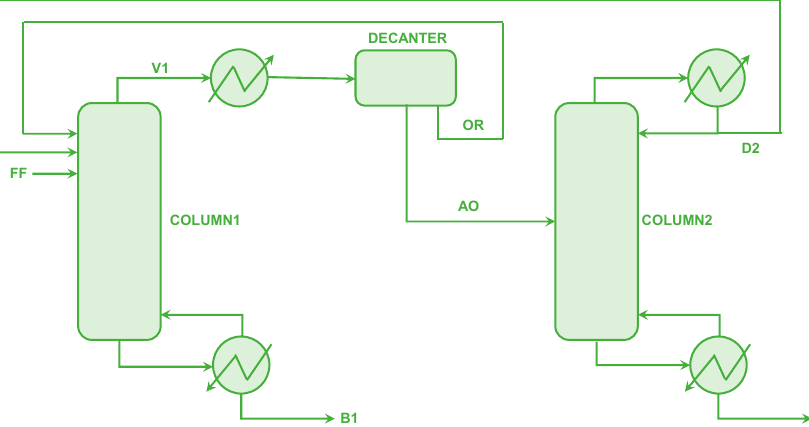
Figure 1. Scheme of the heterogeneous azeotropic separation of the 2-propanol + water mixture: AO, aqueous phase exiting the decanter; B1, bottom product of COLUMN 1; B2, bottom product of COLUMN2; COLUMN1, heteroazeotropic distillation column; COLUMN2, entrainer recovery column; D2, distillate product of COLUMN2; FF, fresh feed; OR, organic phase exiting the DECANTER; V1, vapor stream exiting the top of COLUMN1.